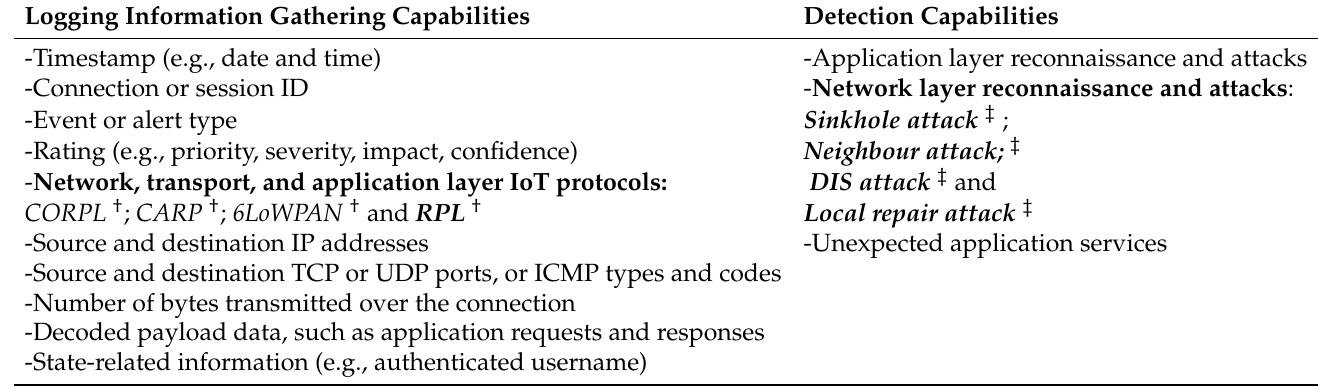
Table 2. Common logging information gathering and detection capabilities of perimeter security solutions. Those who interact with IoT protocols are highlighted in